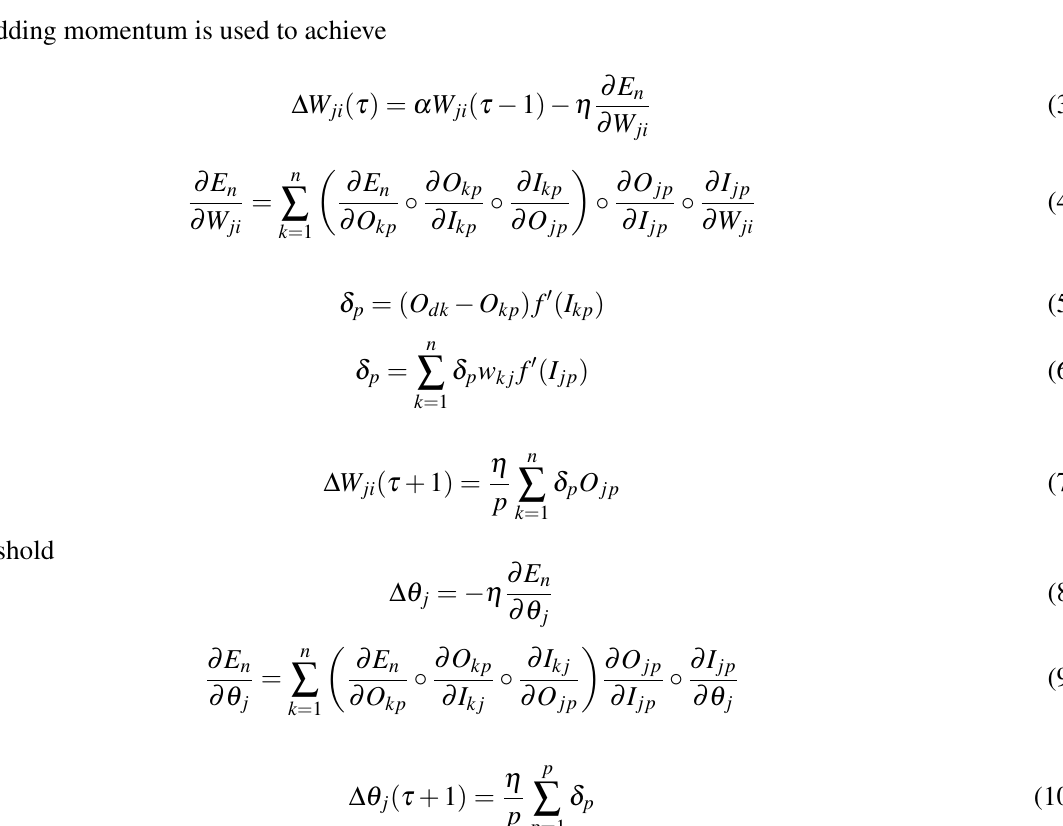
Fig. 1 The structure of the neural network optimisation